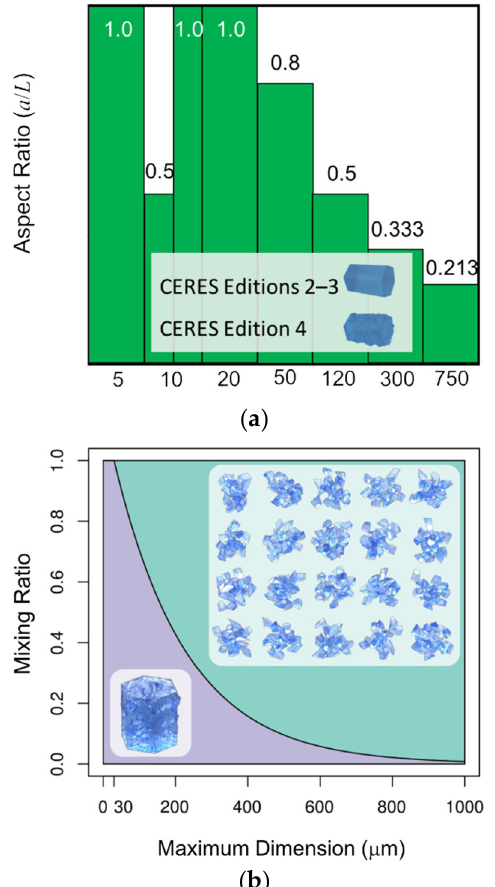
Figure 11. ( a ) Ice cloud models used for CERES Editions 2–4; and ( b ) a two-habit model as a candidate ice model for future CERES Edition 5.